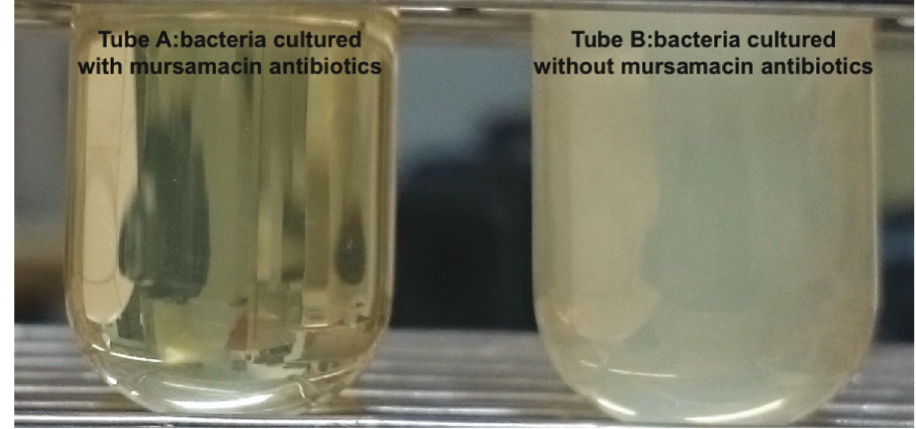
Figure 2. Inhibition of methicillin-resistant S. aureus by mursamacin antibiotics. MRSA cultures were incubated with (tube a) and without (tube b) mursamacin antibiotics respectively. A clear tube denotes no bacterial growth while turbid tube denotes bacterial growth.